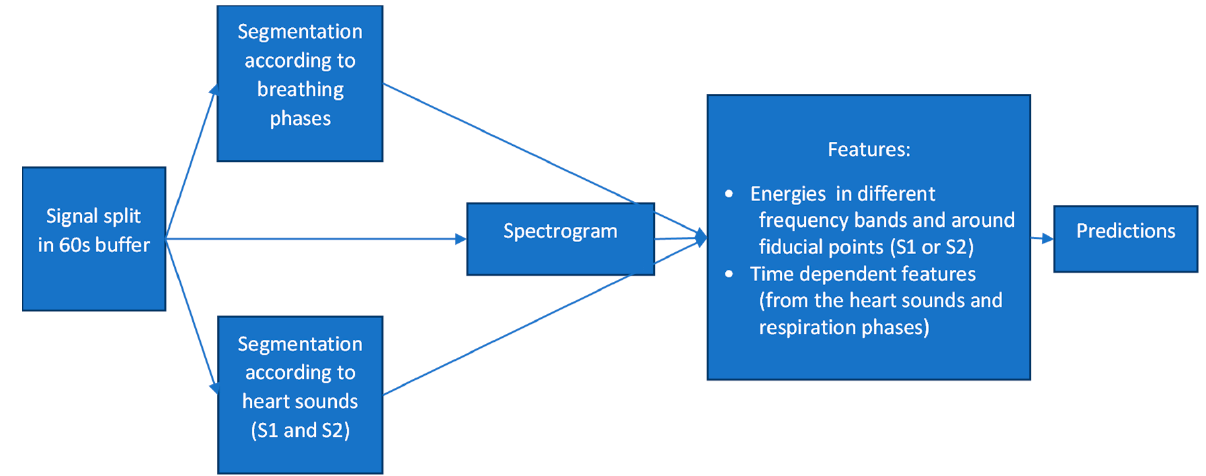
Figure 2. Schematic sketch of the developed algorithm.